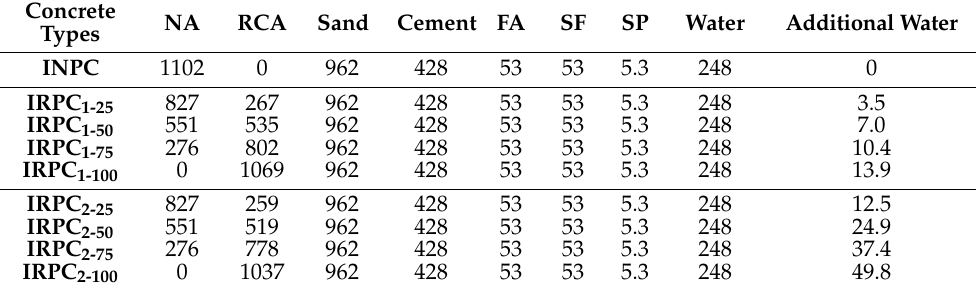
Table 3. Mixture proportions of innovative pervious concrete specimens (kg/m 3 ).